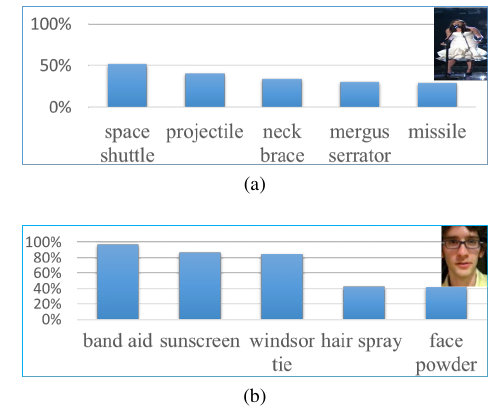
Figure 2. The classification results of TB50 target using the GoogLeNet. The vertical axes is the percentage of the target identified as different